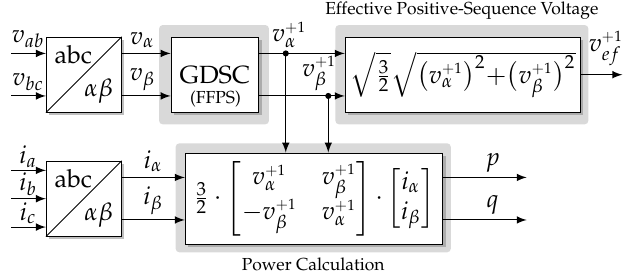
Figure 10. Method for computing the effective voltage and the active and reactive power calculation.